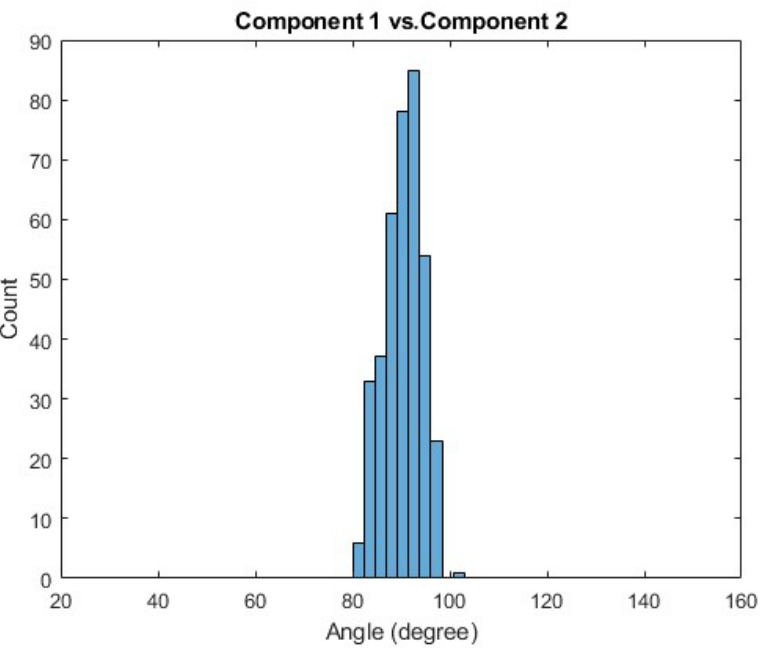
Figure A2. Histogram of the comparisons between the first principal component of some Trial A and the second principal component of some Trial B, where these comparisons are made across all trials and subjects.